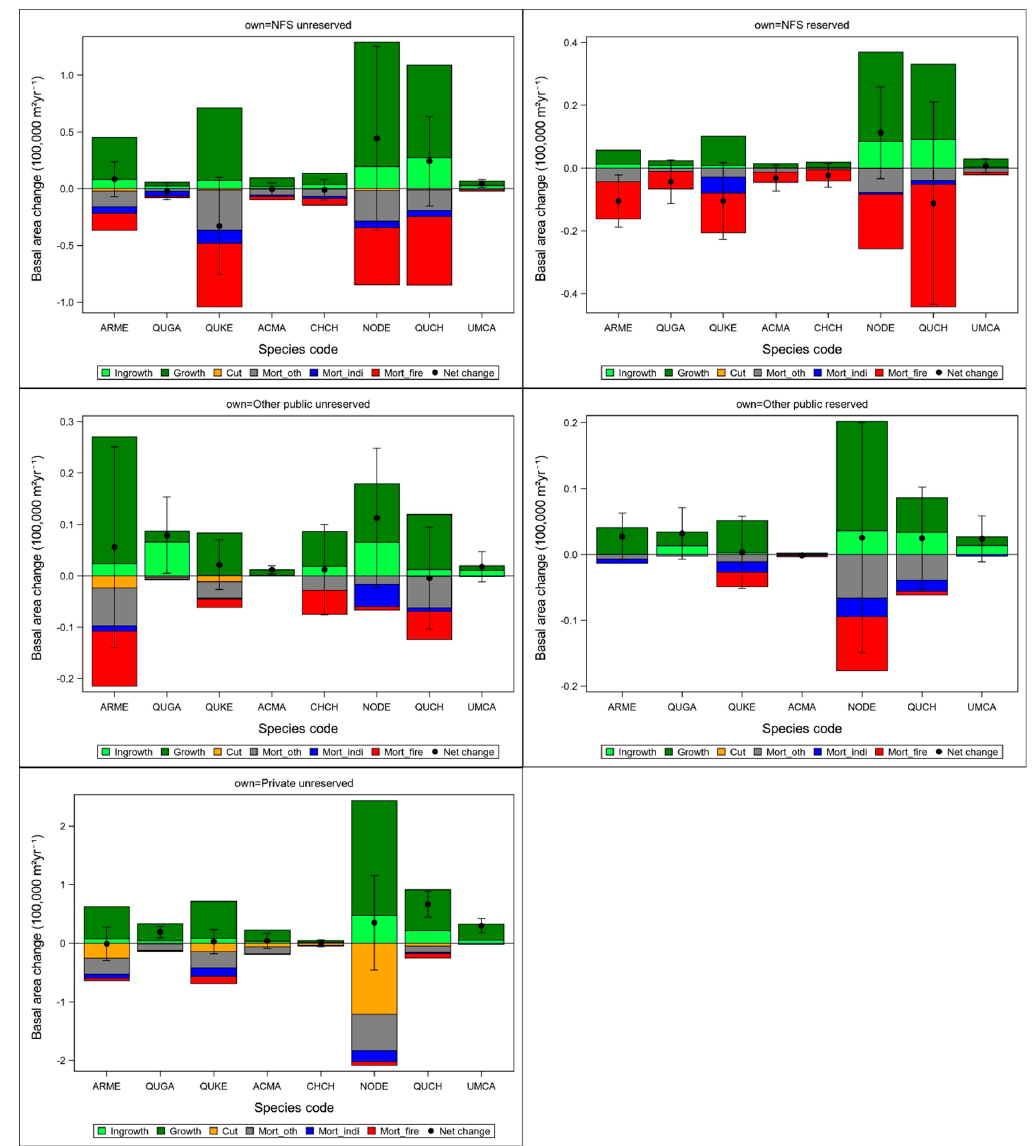
Figure 9. Basal area change by ownership and reserve status with net change shown by points with 95% confidence interval bars.